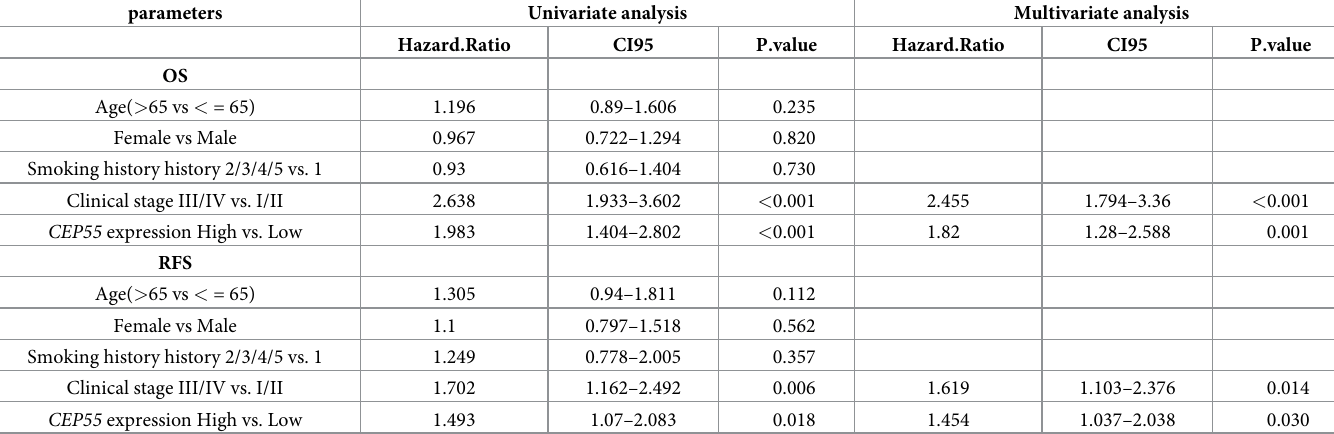
Table 3. Univariate and multivariate analyses of OS/RFS in patients with primary LUAD. parameters